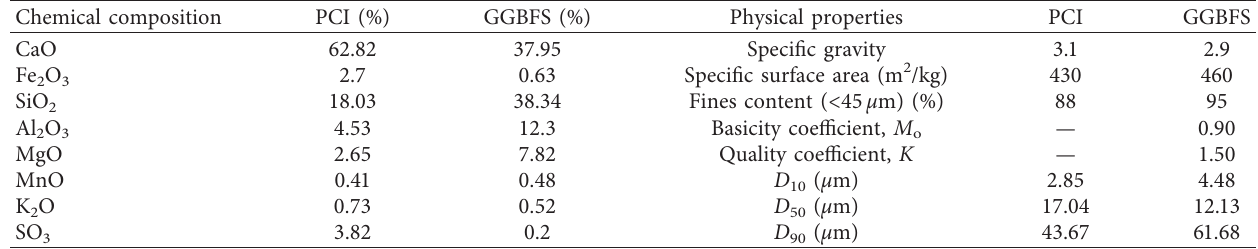
Table 1: Chemical and physical properties of PCI and GGBFS.